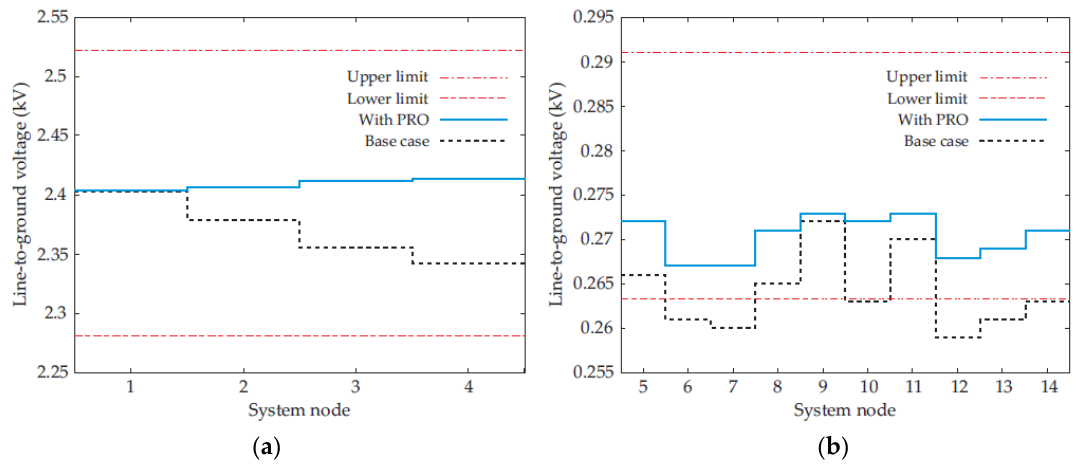
Figure 13. Line ‐ to ‐ ground voltage profiles for ( a ) the main feeder and ( b ) the load areas and transformers. Figure 13. Line-to-ground voltage profiles for ( a ) the main feeder and ( b ) the load areas and